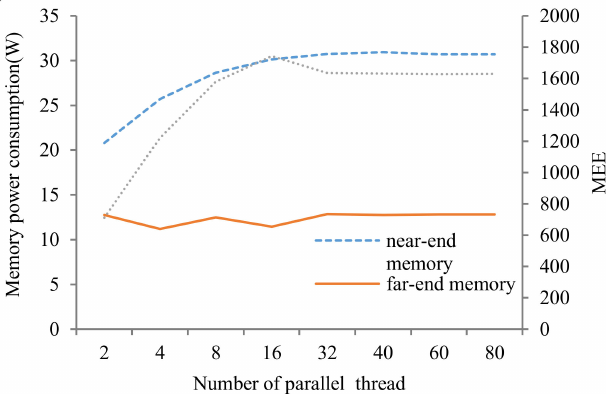
Figure 17. Experiment of multi-thread STEAM array size of 128 G under NUMA